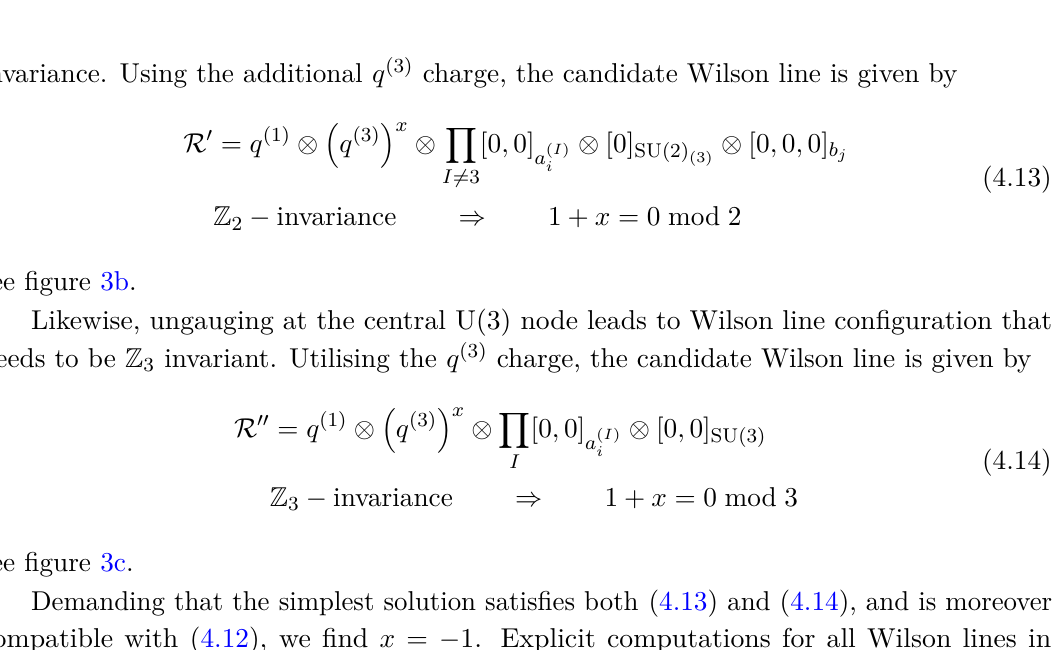
Figure 3. Affine E 6 Dynkin quiver and different choices of ungauging. Here the superposition of a circle and a square, called squircle, represents the node where the diagonal U(1) is ungauged. The Wilson lines defined in each theory have identical B-twisted indices, see table